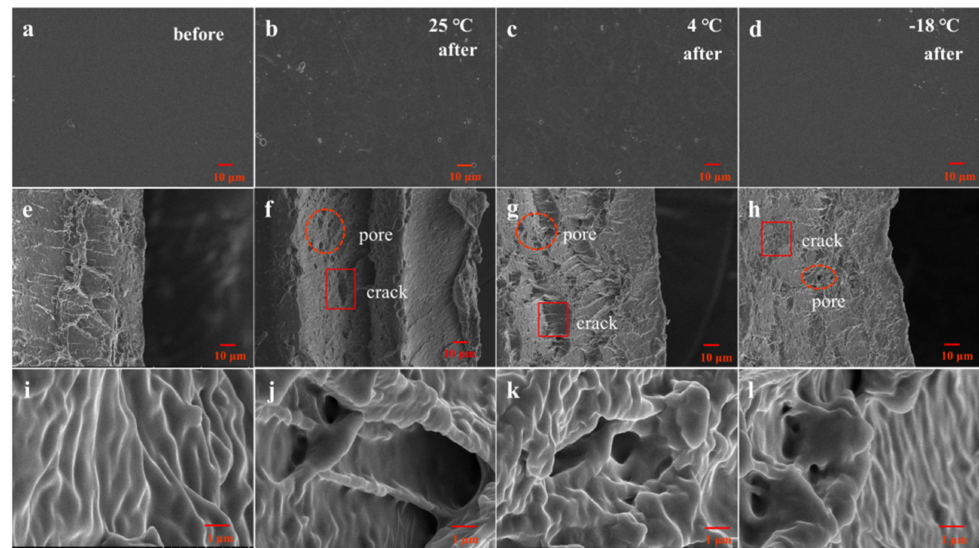
Figure 4. SEM of SPI edible films’ surfaces and sections before and after storage for 6 weeks at different temperatures (25 ◦ C, 4 ◦ C, and − 18 ◦ C). Columns from left to right are images of blank SPI films (with no storage) and films after 6 weeks of storage at 25 ◦ C, 4 ◦ C, and − 18 ◦ C respectively; Rows from top to bottom, are the surface of SPI films (magnification 1000 × ), section of SPI films (magnification 1000 × ), and section enlarged view of SPI films (magnification 15K × ),